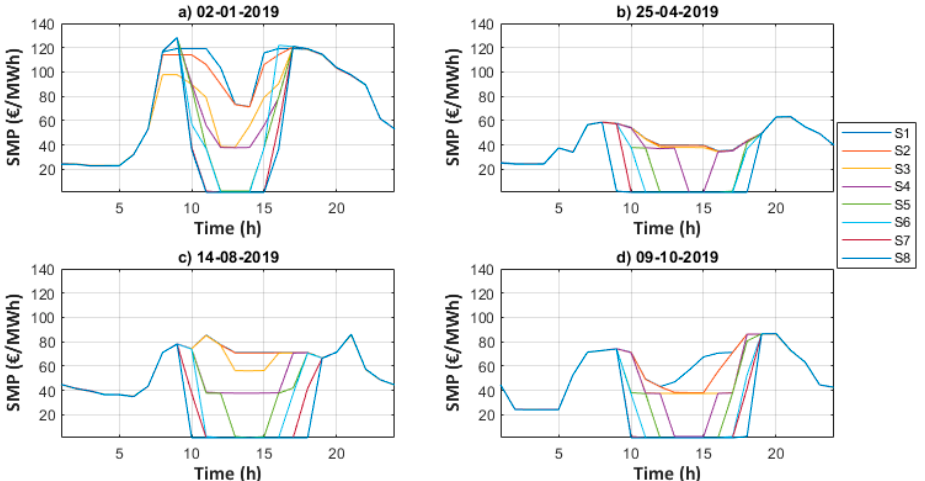
Figure 3. Daily average SMP per test day: ( a ) 2 January 2019, ( b ) 25 April 2019, ( c ) 14 August 2019, and ( d ) 9 October 2019. (source: Authors).